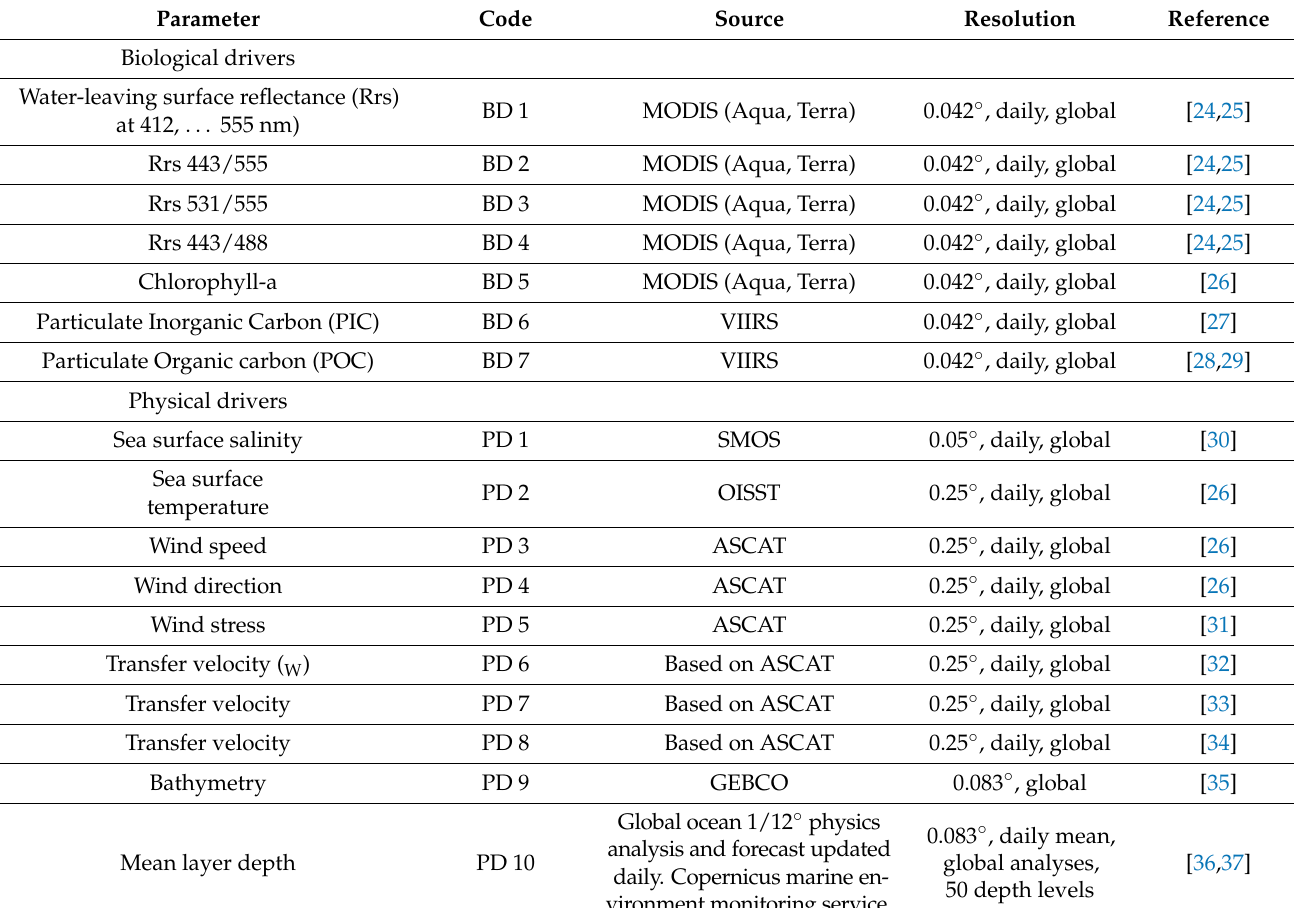
Table 2. Co-temporal and co-located environmental drivers derived from independent sources that range from satellite remote sensing and model analyses to empirical algorithms were